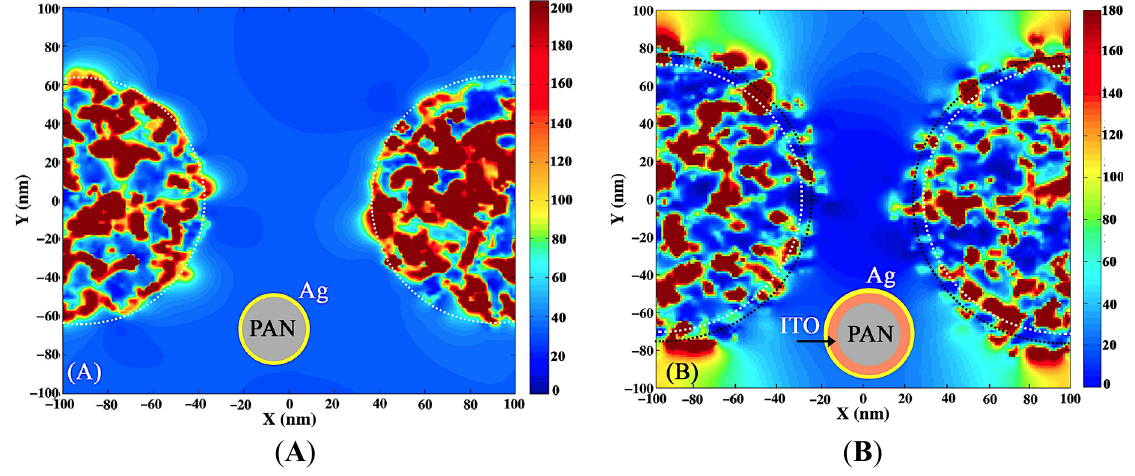
Figure 7. xy distribution of the electric field component of light at the bonding frequency of the Ag nanoshell with ( A ) PAN ( B ) ITO